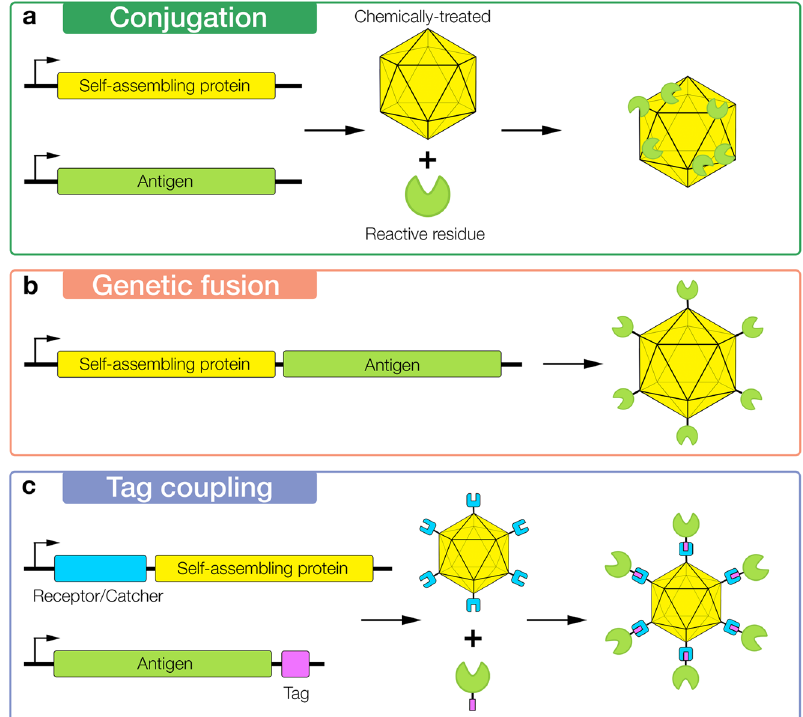
Fig. 3 Methods of Antigen attachment to nanoparticle platform. Protein sequences are indicated by rectangular boxes, arranged left to right from N to C terminals. Protein nanoparticle platforms are represented by a yellow icosahedron and antigens are represented as a green circular sector. a A typical chemical conjugation scheme for protein nanoparticles, which involves the chemical treatment of a reactive amino acid on either the nanoparticle or antigen to conjugate with a reactive amino acid on the other respective protein. In this case, the nanoparticle is chemically treated to bind with a reactive amino acid residue on the antigen. b Genetic fusion with the platform, indicated by a distinct black line between the antigen and nanoparticle. c An example of tag-coupling systems, where the genetic fusion of a protein receptor or protein catcher, represented as cyan colored squares with a cavity, to one component allows for binding to another component through a genetically fused tag, represented as a small pink